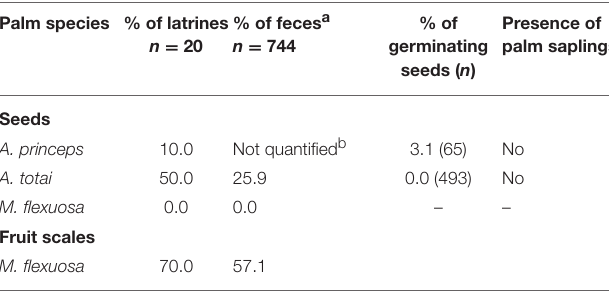
TABLE 3 | Frequency of latrines and individual feces of South American tapir with palm seeds and epicarp scales of M. flexuosa . Palm species % of latrines n =